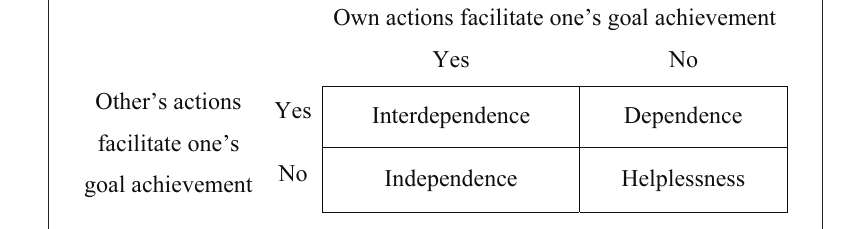
Figure 1. Interrelations among individuals (Johnson, D. W., Johnson, R. T.,